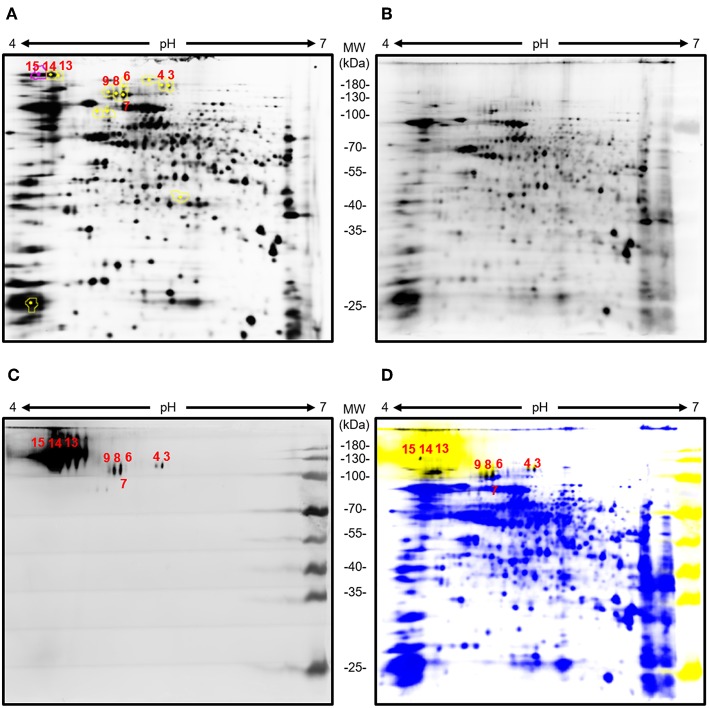
Analysis of young A. flavus mycelia cell wall proteins by 2DE and immunoblot with AP3 as the detection antibody. Total Aspergillus mycelia and CWPs (100 μg) were labeled with Cy3 and separated in the first dimension on a 7-cm pH 4–7 immobilized pH gradient strip followed by separation in the second dimension by 12.5% (v/v) SDS-PAGE. Separated Aspergillus CWPs were transferred onto a nitrocellulose membrane. Immunoblot detection was carried out using purified mAb AP3 (400 ng/ml) and a goat anti-mouse Cy5-labeled antibody (120 ng/ml). Gels and membranes were scanned with an Ettan DIGE Imager equipped with appropriate filters for Cy3 and Cy5, and images were processed with DeCyder software v7.0. (A) Cy3 labeled 2D gel of young A. flavus proteins. (B) Cy3-labeled total CWPs blotted onto a membrane. (C) CWPs specifically detected by mAb AP3 visualized using a Cy5-labeled antibody. (D) Overlay of Cy3-labeled total CWPs (blue) and AP3-recognized CWPs (yellow). Shared protein spots are highlighted in black. Numbers indicate protein spots selected for analysis by mass spectrometry.